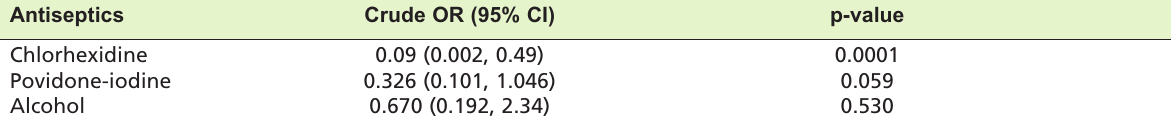
Simple logistic regression analysis showing the effectiveness of antiseptics in experimental groups Table III: Antiseptics Crude OR (95% CI) p-value Chlorhexidine 0.09 (0.002,